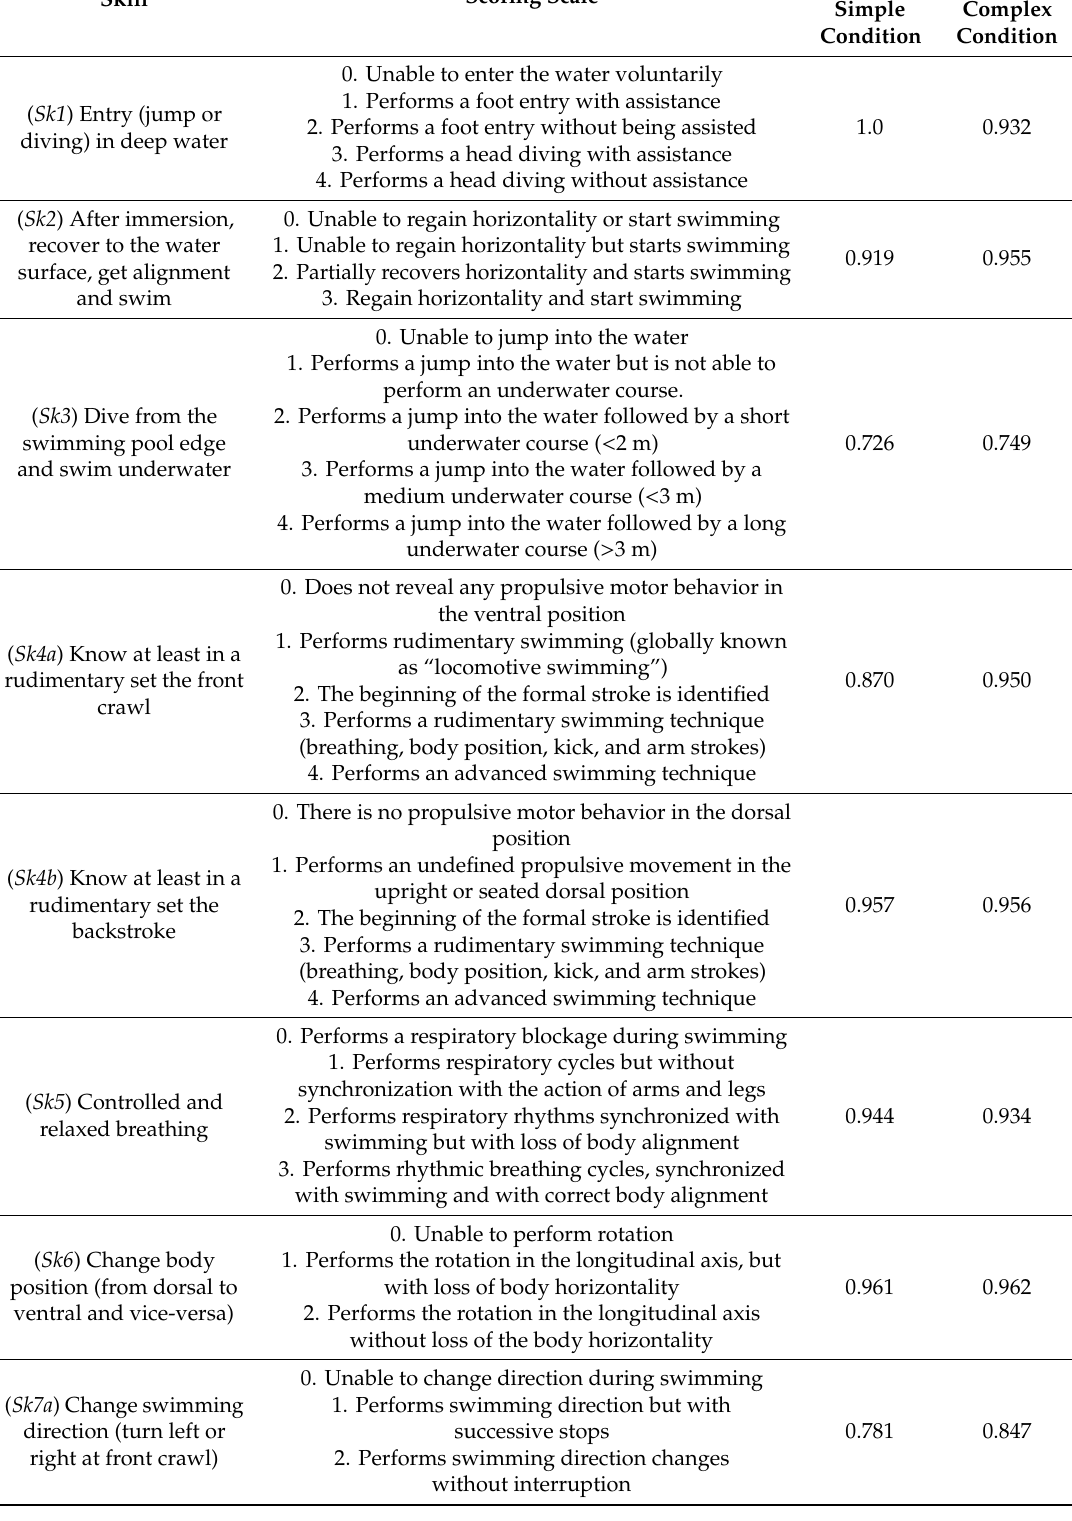
Table 1. Scoring scale to evaluate aquatic competence related to the risk of drowning. Skill Scoring Scale